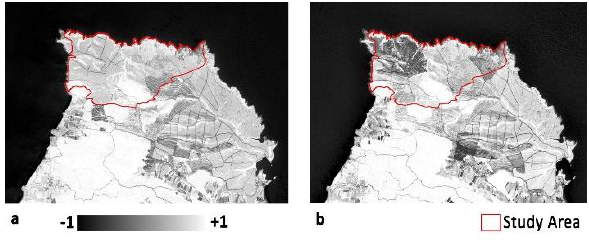
Figure 3. Sentinel-2 NDVI images of the study area for